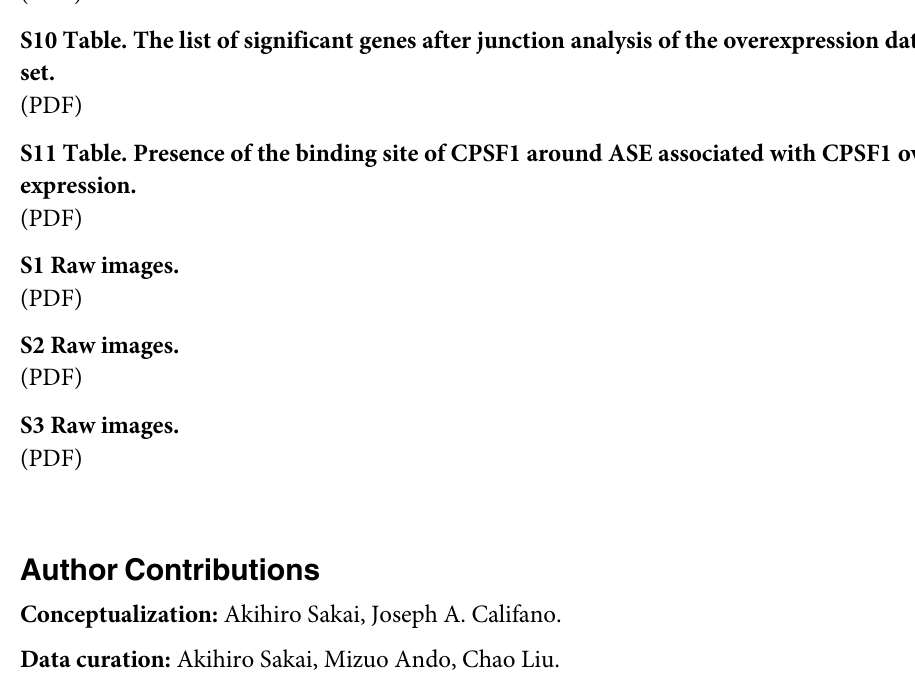
S8 Table. The number of ASEs in each sample of the TCGA cohort. S9 Table. The list of significant genes after junction analysis of the knockdown dataset. S10 Table. The list of significant genes after junction analysis of the overexpression data- set. S11 Table. Presence of the binding site of CPSF1 around ASE associated with CPSF1 over-